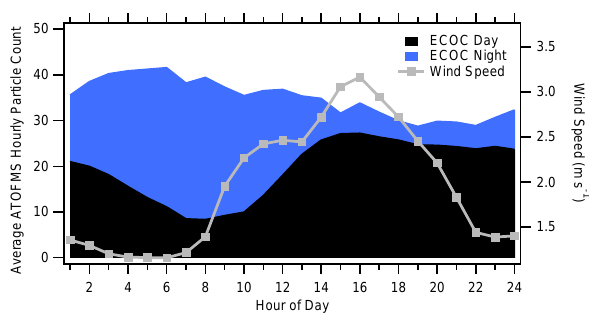
Fig. 10. Stacked diurnal trends for the ECOC Day and ECOC Night factors, along with the campaign diurnal averaged wind speed (the early morning peak beginning at 06:00 and ending at 17:00 on 5 July was removed from the calculation of the ECOC Night factor diurnal trend to highlight the trend present for other